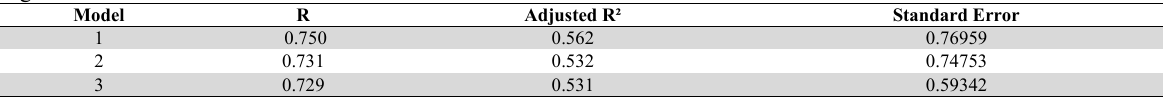
Regression Test